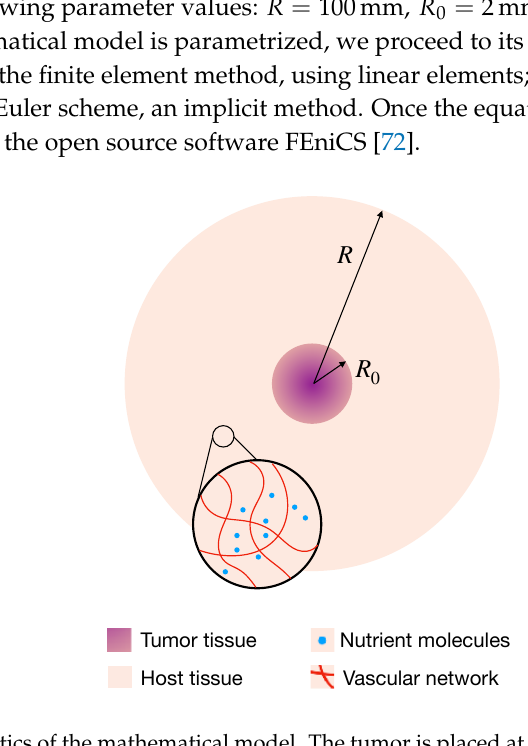
Figure A1. Schematics of the mathematical model. The tumor is placed at the center of the surrounding tissue, and the inlet highlights the presence of the vascular network and nutrient molecules in the system. R 0 and R denote the initial tumor radius and the computational domain,